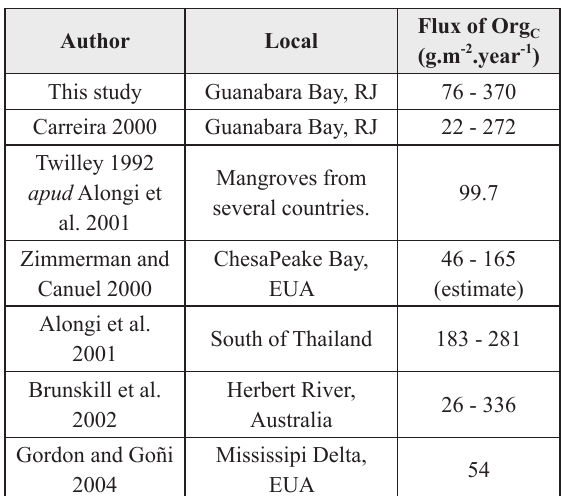
Figure 4 - Flux of organic carbon in the sediment core. Flux of organic carbon in sediments from different environment all over the